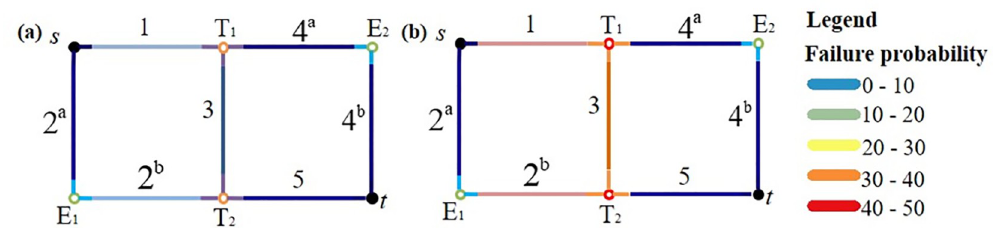
Fig 9. Calculation results of simple pipeline network connectivity in example. (a) Not considering the nodes, (b) Considering the nodes.